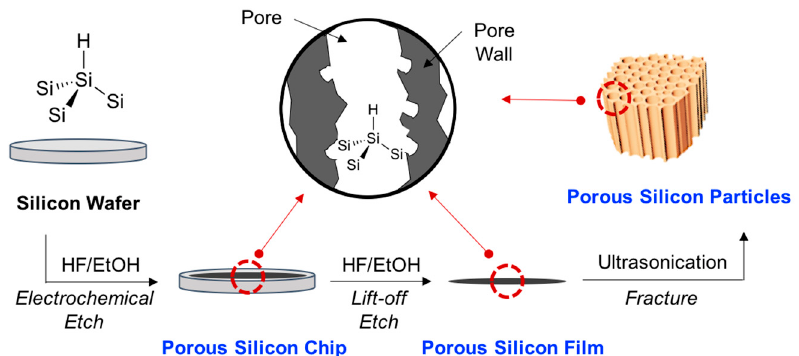
Figure 1. Schematic illustration for the preparation of porous silicon by electrochemical etching and ultrasonication. A porous silicon layer is generated on the surface of the silicon wafer using electro chemical etching, and the layer can be separated from the wafer using lift-off etch. Porous silicon micro- and nano-particles can be prepared using ultrasonication fracturing. The surface of the resulting porous silicon is covered mainly with silicon-hydrogen (Si–H) and partly with silicon-oxygen (Si–OH, Si–O–Si).